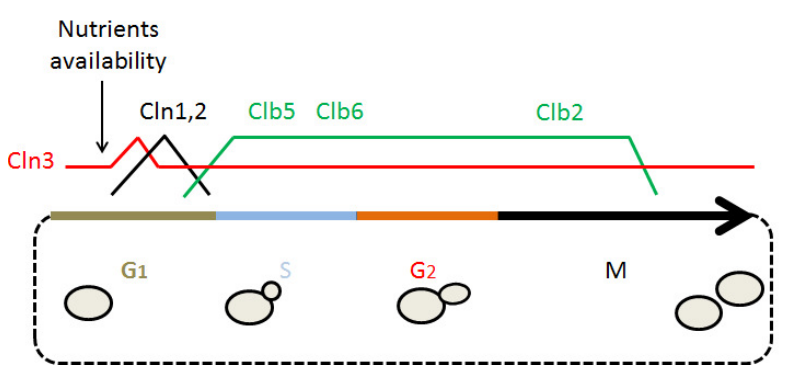
FIGURE 1: The S.cerevisiae cell cycle. Schematic representation of the yeast cell cycle phases showing the shape of the cells in each phase. Temporal relationship of the different elements represented in the fig- ure with the cell cycle phases, including relative CDK (cyclin-dependent kinases) activity and the presence of the different cyclins throughout the cell cycle. *The presence of the Cln3 protein is fairly con- stant throughout the cell cycle but it is only biologically available at the moment indi- cated.